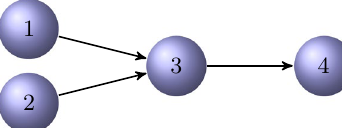
Fig. 1 A directed 3-chained graph G with initial vertex v